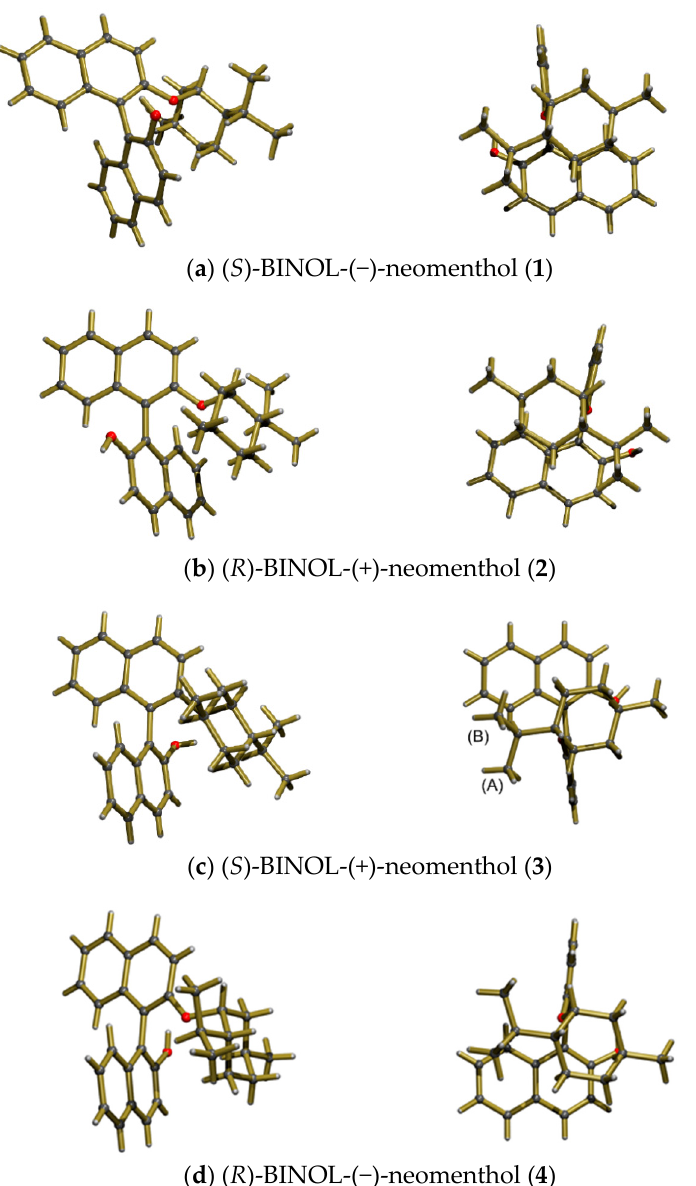
Figure 1. Two different perspectives of chiral moieties found in crystal structures of each stereoiso- mers 1 – 4 , drawn with PLATON [42] and POVRAY [43]. Coloured balls representing atoms are all of the same fixed size, thus not showing any thermal displacements.